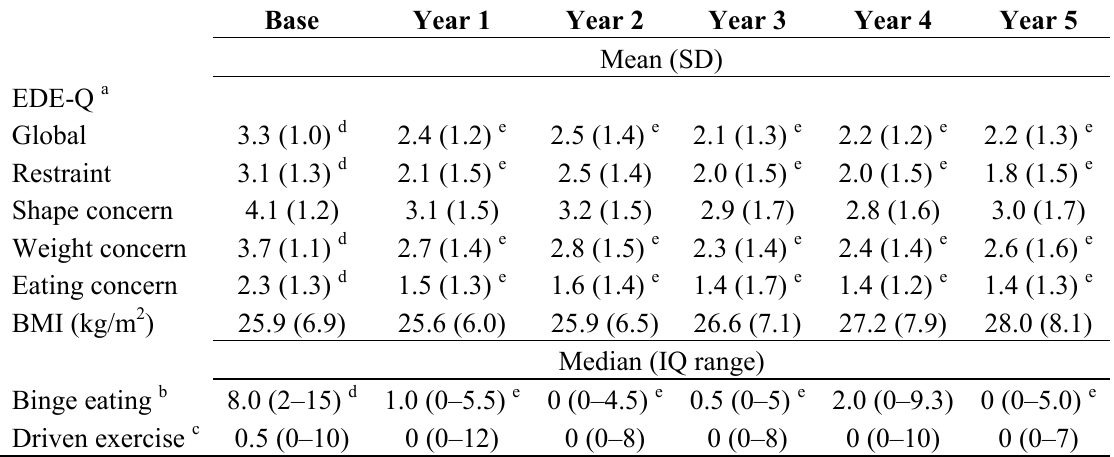
Table 3. Comparative eating disorder features over each of the 5-years for Cohort 2 ( n =